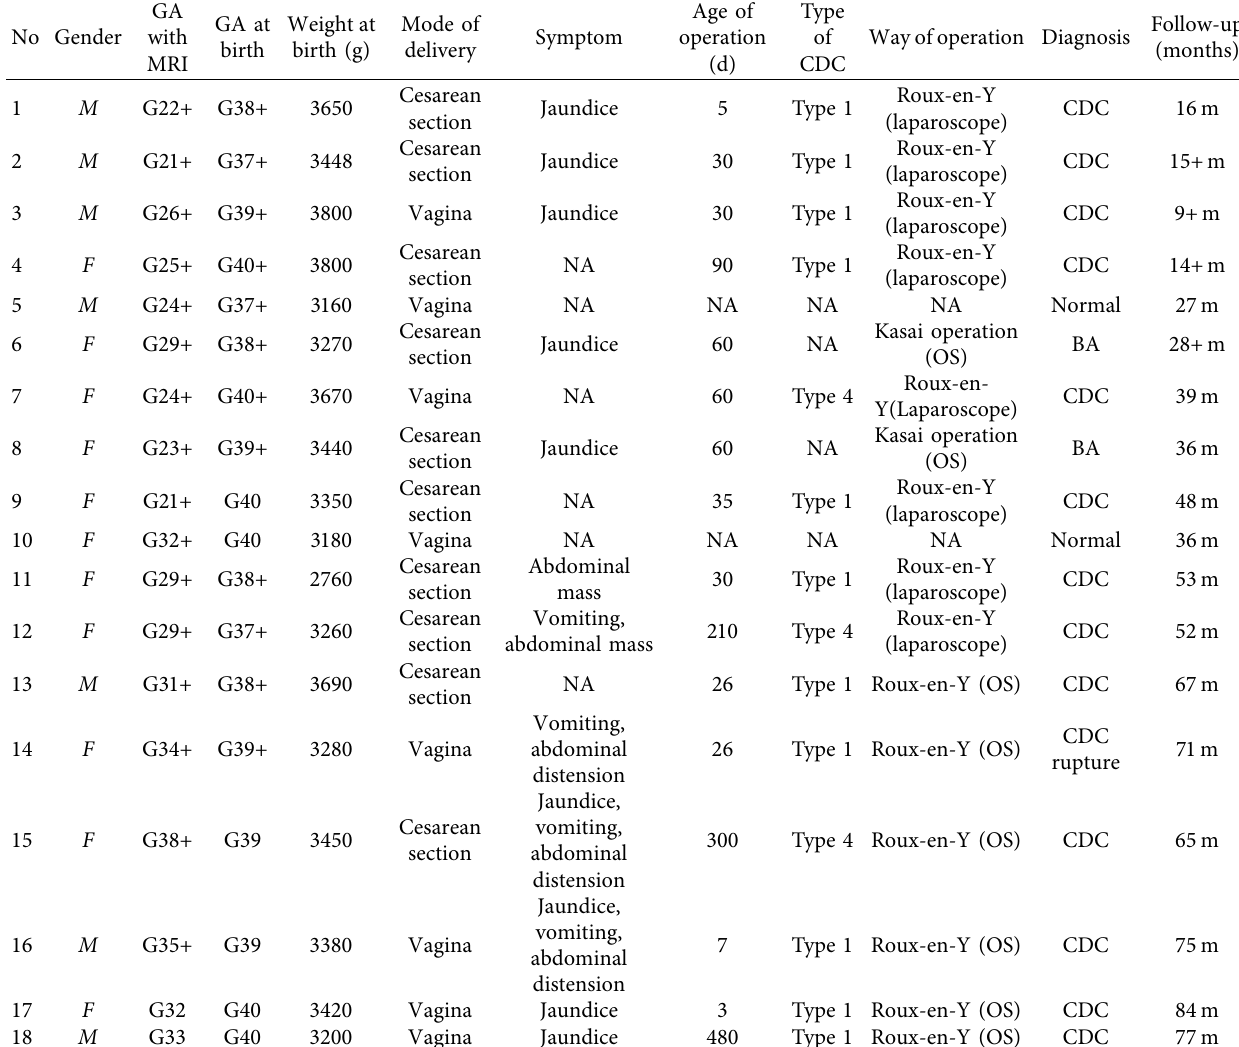
Table 1: Clinical data and postnatal outcomes of 18 fetus with CDC by MRI